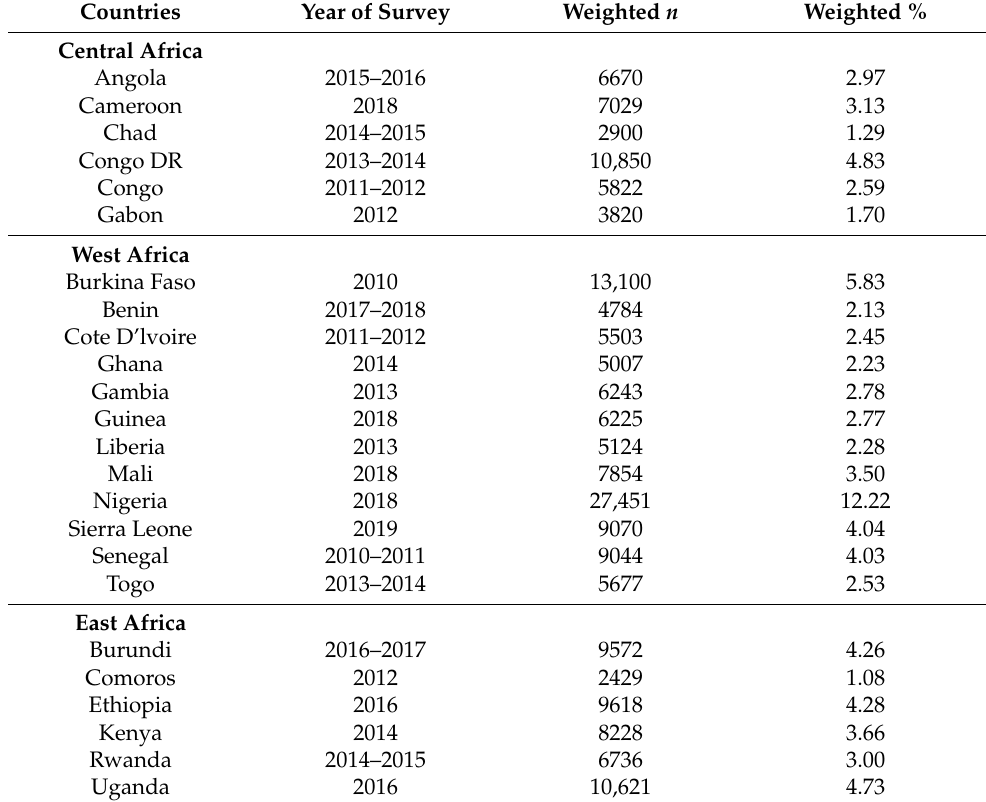
Table 1. Description of